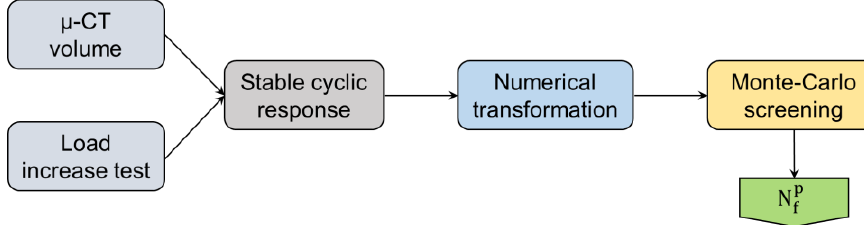
Figure 6. The graphical algorithm of the fatigue lifetime calculation model.